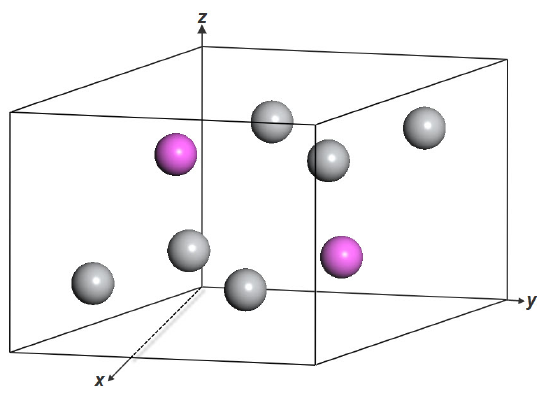
Figure 1. Crystal structure of Ti 3